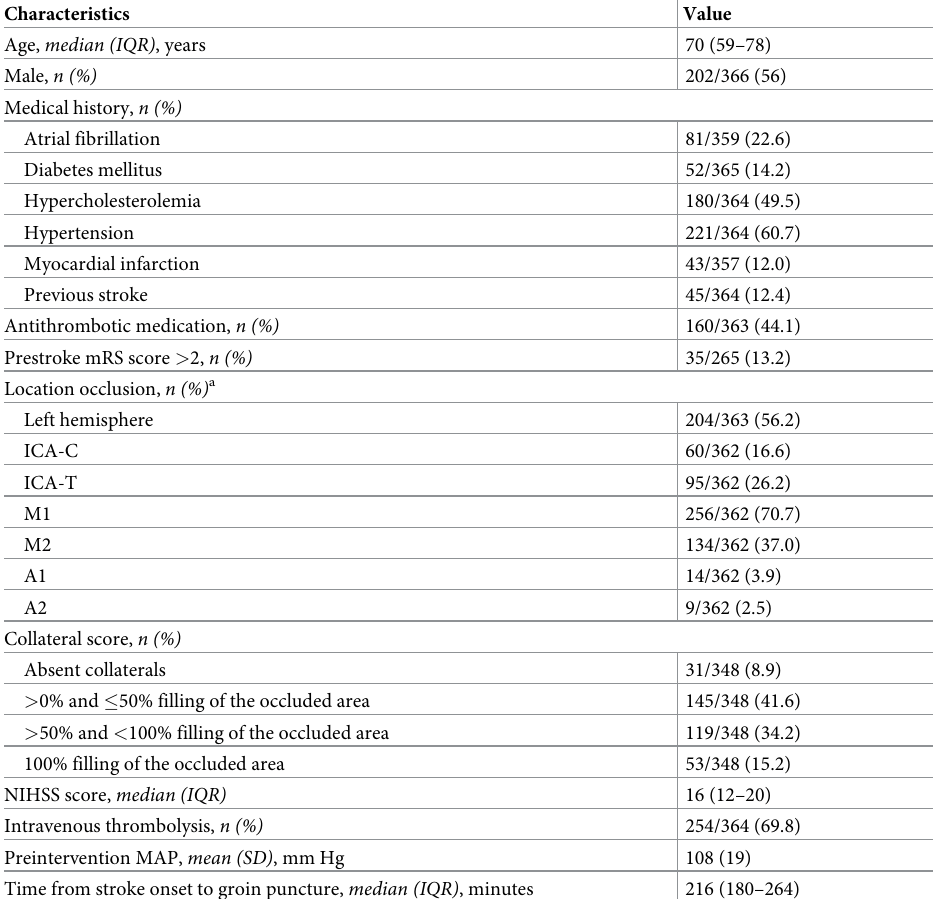
Table 1. Baseline